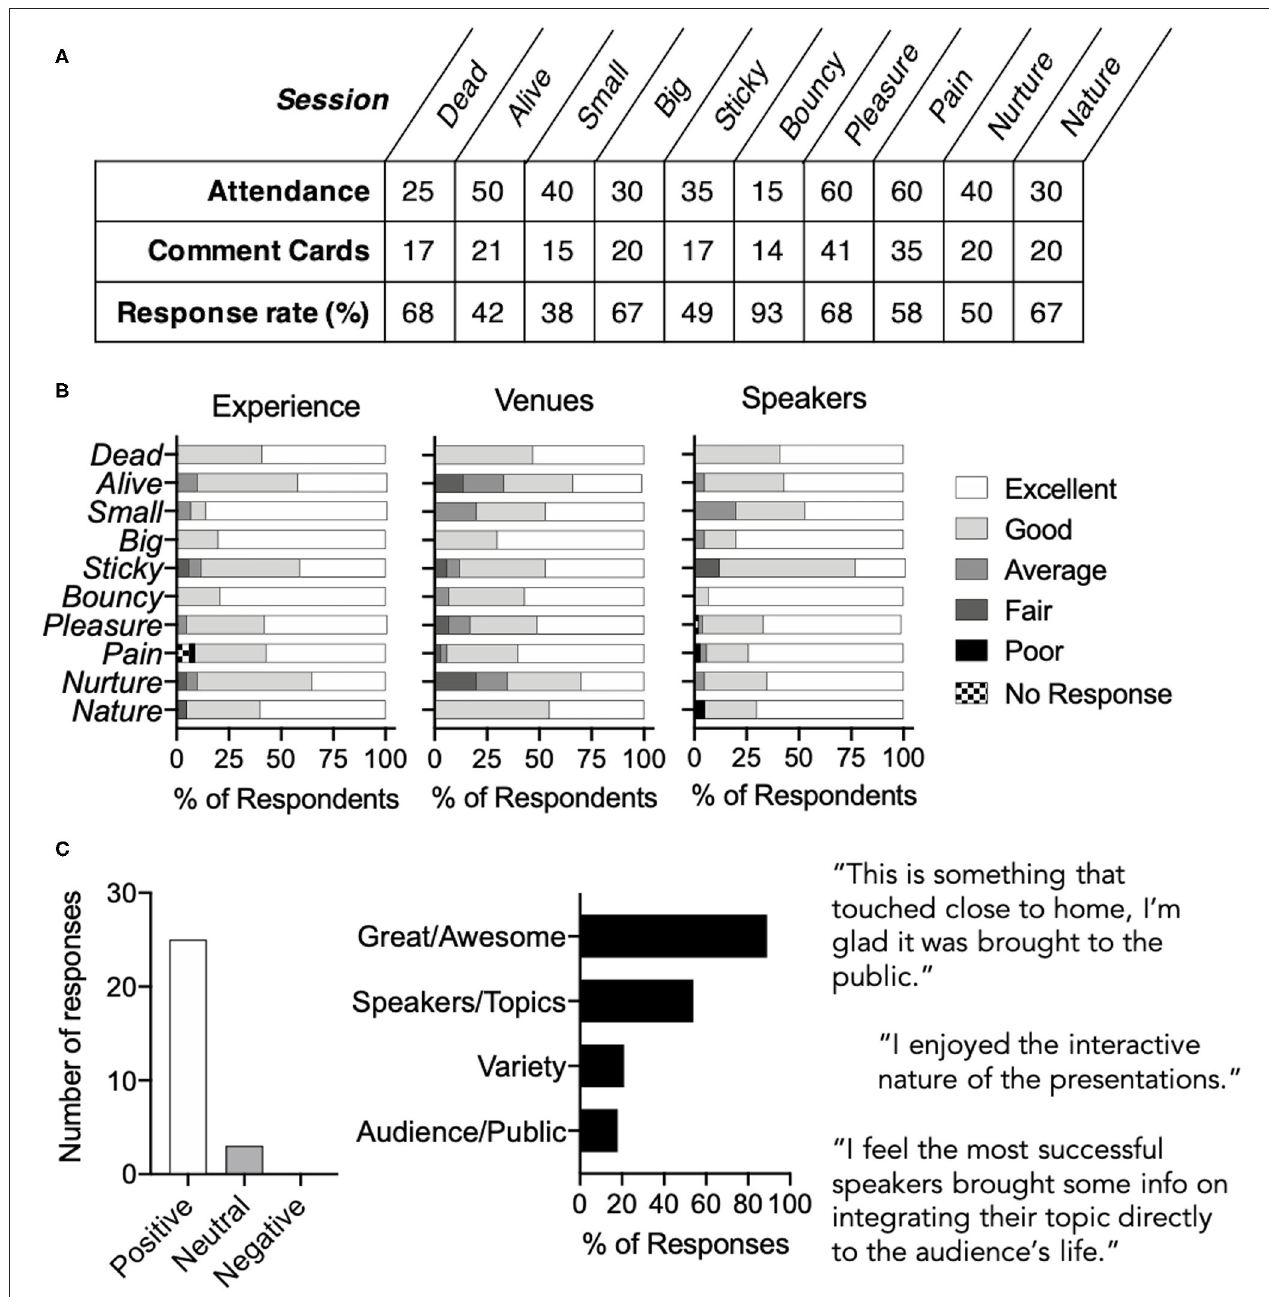
FIGURE 2 | Feedback Assessed During the Second Year of the EiS festival. Assessments were made using comment cards available to attendees at each of ten sessions. (A) Attendance and comment card response rates. (B) Attendee rankings for experience, venue, and speakers. (C) Qualitative analysis of 28 audience comments by tone and thematic classification with selected quotes